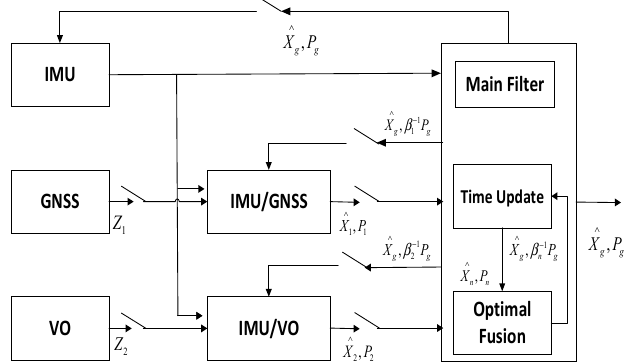
Figure 3. Federated Kalman filter.